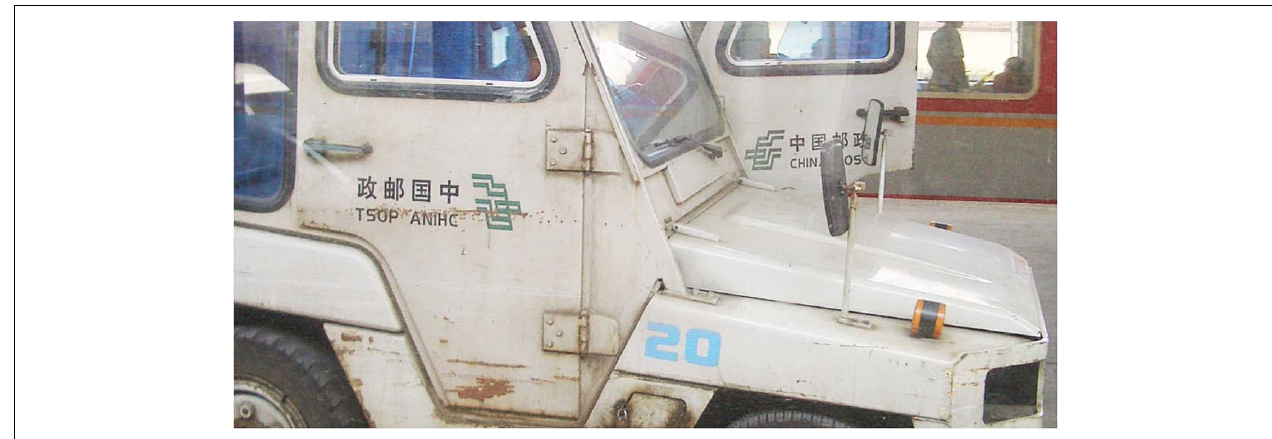
run in the LR direction. (Source: upload.wikimedia.org/wikipedia/commons/ 7/7e/VM_5485_China_Post_Office_car_at_Zhengzhou_Train_Station.jpg; accessed 6th July